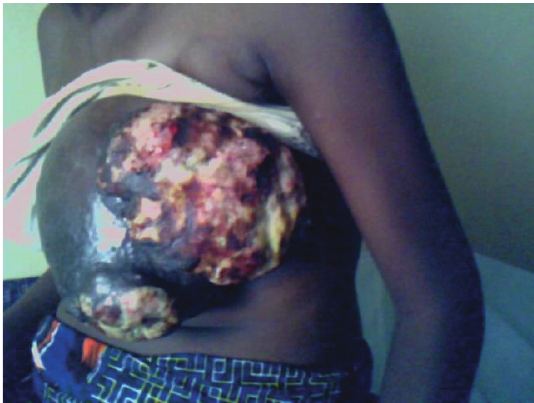
Figure 1: Showing extensively fungating and ulcerated breast lesion.